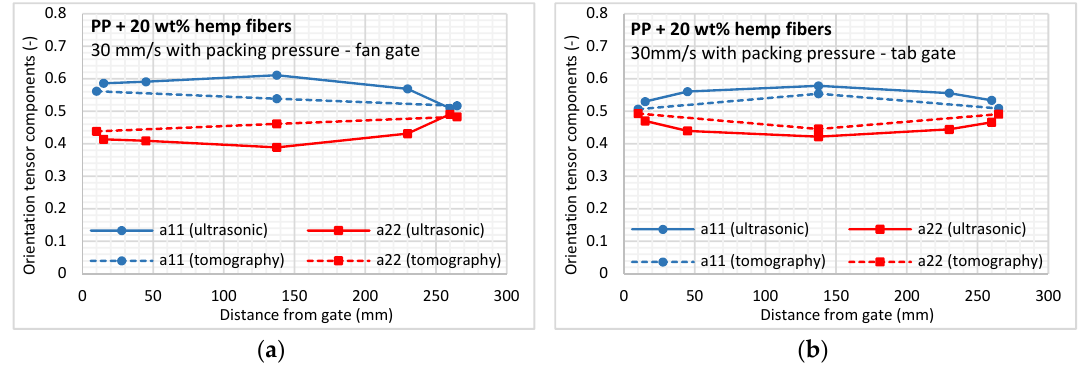
Figure 12. In-plane fiber orientation components from ultrasonic and tomography methods obtained for the ( a ) fan gate and ( b ) tab gate configurations.